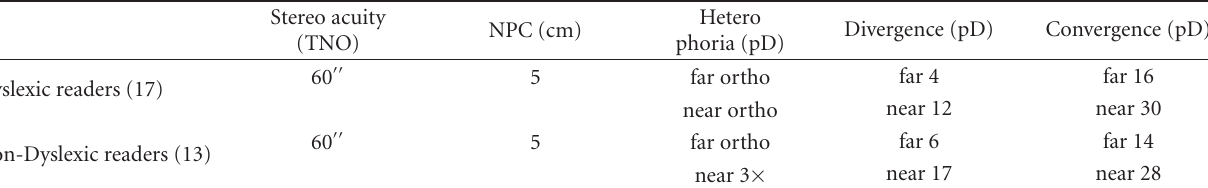
Table 1: Clinical characteristic of